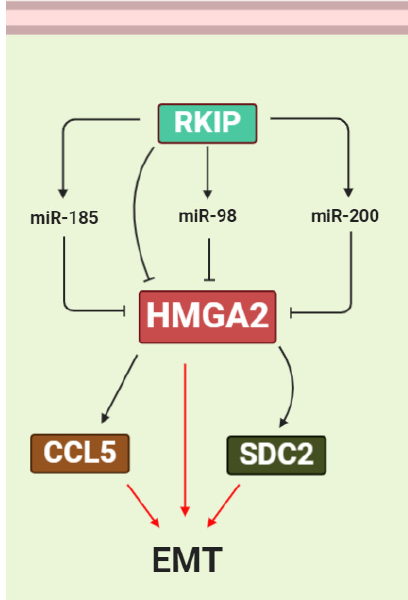
Figure 6. HMGA2 is regulated by the RAF kinase inhibitor protein (RKIP) pathway. RKIP suppresses HMGA2 expression directly, as well as indirectly, by inducing the miRNAs miR-185 , miR-200 , and miR-98 , which target the 3’UTR of HMGA2 mRNA. Suppression of HMGA2 via RKIP and miRNAs reduces the expression of the EMT-promoting factors CCL5 and SDC2.